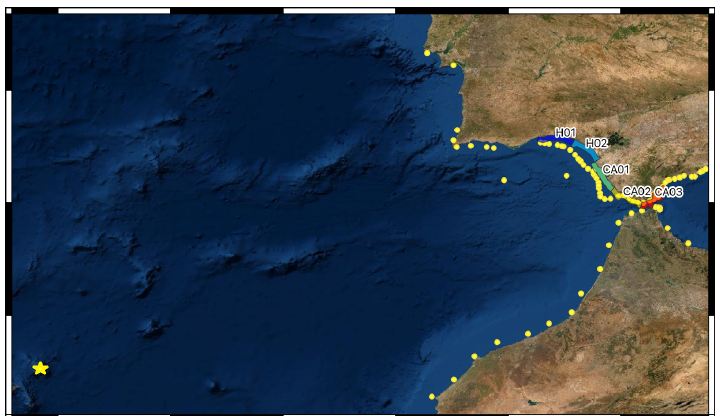
(cid:63) Figure 1. Points and coastal zones of interest. The marks the approximate location of the center of the Horseshoe fault. The coast is divided into 5 sections, two for Huelva coast and three for Cádiz. We focus on CA01. Yellow dots are the virtual gauges considered by the Spanish